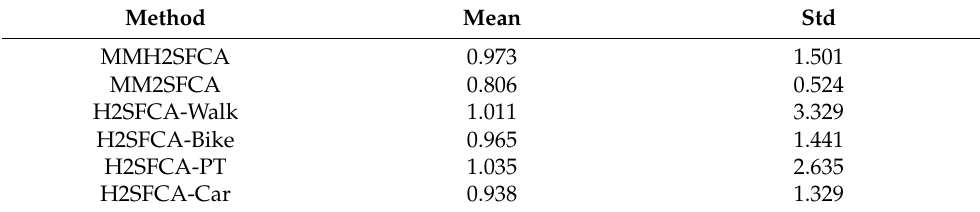
Table 4. Descriptive statistics of accessibility